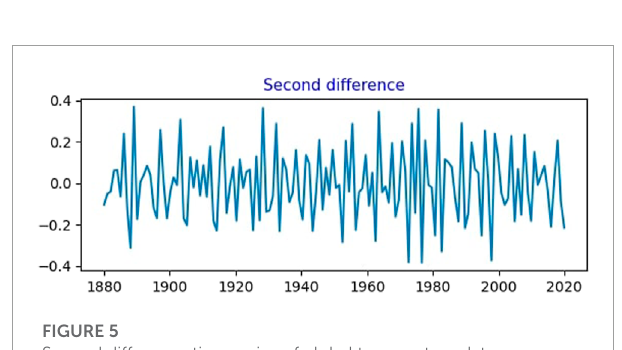
FIGURE 5 Second difference time series of global temperature